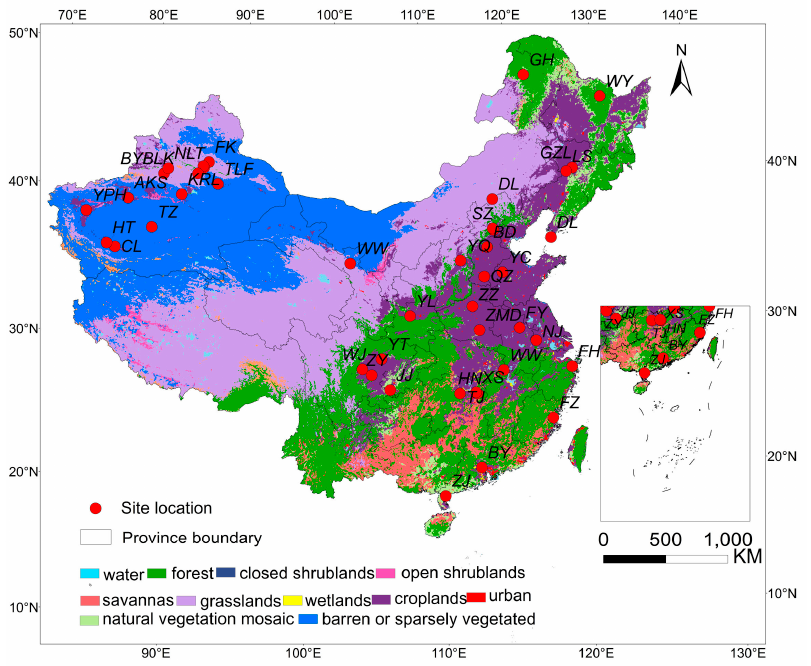
Figure 1. Spatial distribution of ground monitoring NH 3 sites in the Chinese Nationwide Nitrogen Deposition Monitoring Network (NNDMN).